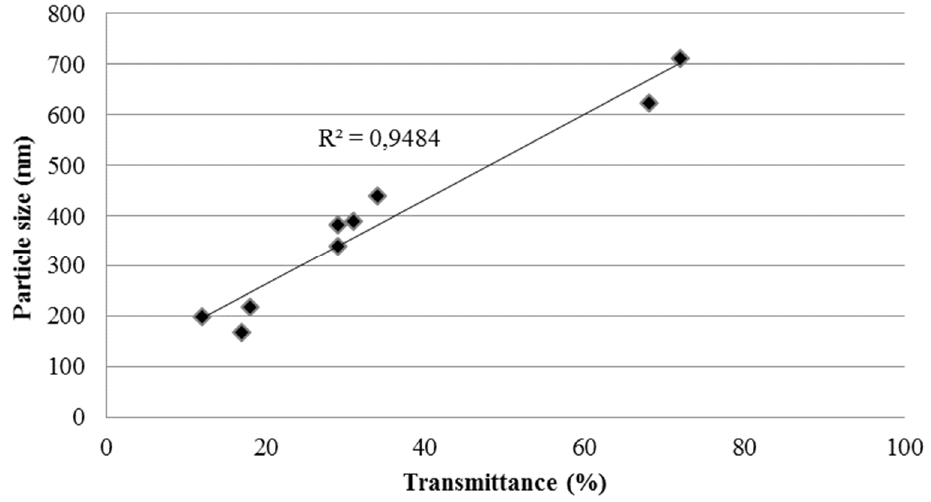
Figure 1. Average particle size vs. transmittance for surfactant mixtures from non-ionic surfactants with the same structures.